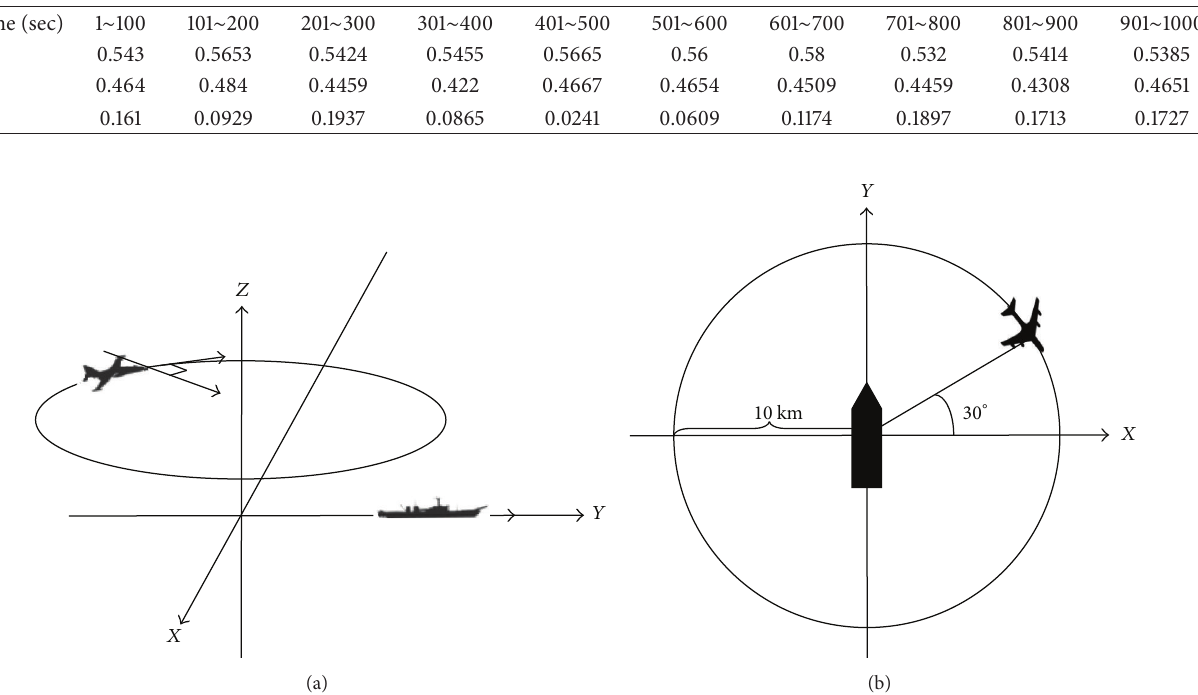
Table 5: Estimated gain parameters for GA based adaptive 𝛼 - 𝛽 - 𝛾 filter.